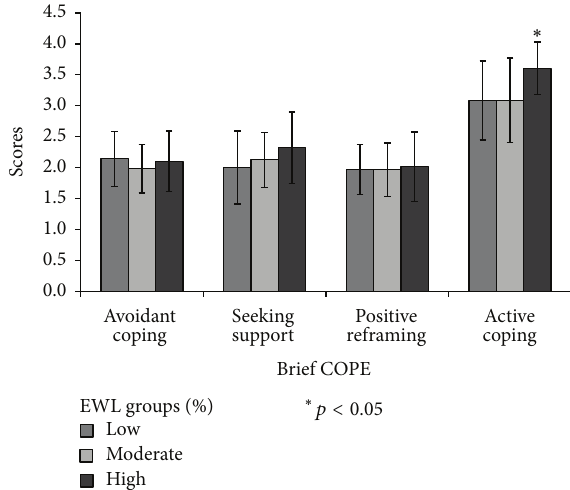
Figure 1: Preoperative coping style according to postoperative %EWL groups. Brief COPE scores before LSG for the groups with low, moderate, and high postoperative %EWL. Bars represent the standard deviation. The asterisk indicates statistically significant group differences between the high-%EWL and low-%EWL groups and the high-%EWL and moderate-%EWL